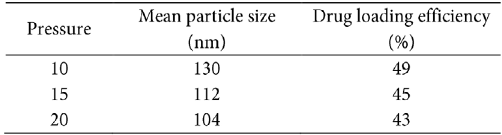
Table 1. Mean particle size of paclitaxel particles and drug load- ing efficiency obtained at 50 ºC, 2 mL/min, DMSO/water ratio of 6 (v/v), ethanol concentration of 7.5% (v/v) and various pressures of 10, 15 and 20